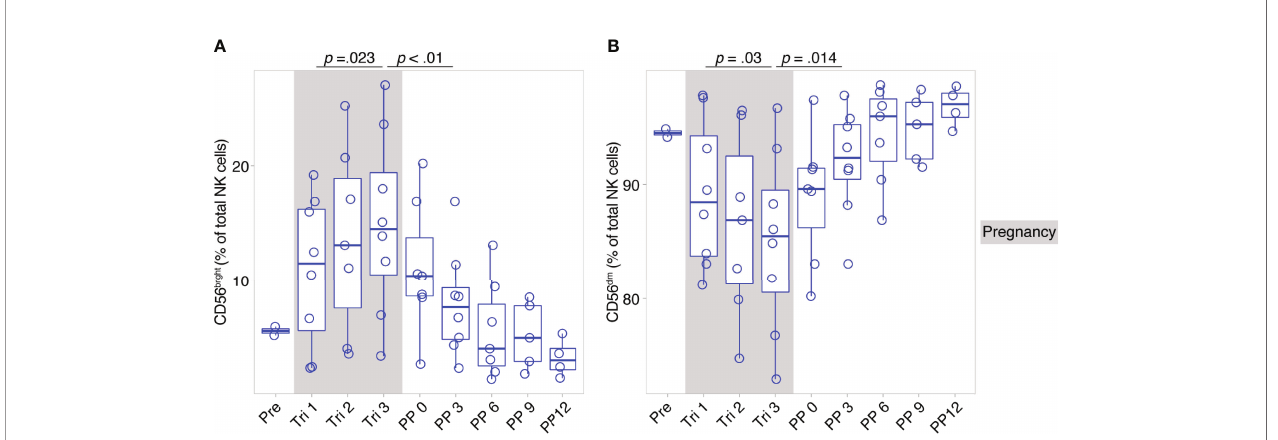
FIGURE 2 | Pregnancy-induced shifts of NK cells throughout and after gestation in Berlin MS cohort. Frequency of CD56 bright NK cells (A) and CD56 dim NK cells (B) in pregnant MS patients (MS, Berlin cohort) shown for each trimester of gestation and 1 year postpartum. Boxplots depict median and inter-quartile range, overlaid with datapoints of individuals. Gray boxes represent pregnancy. Statistics performed by Wilcoxon paired test between trimesters 1 and 3, as well as trimester 3 and 3 months